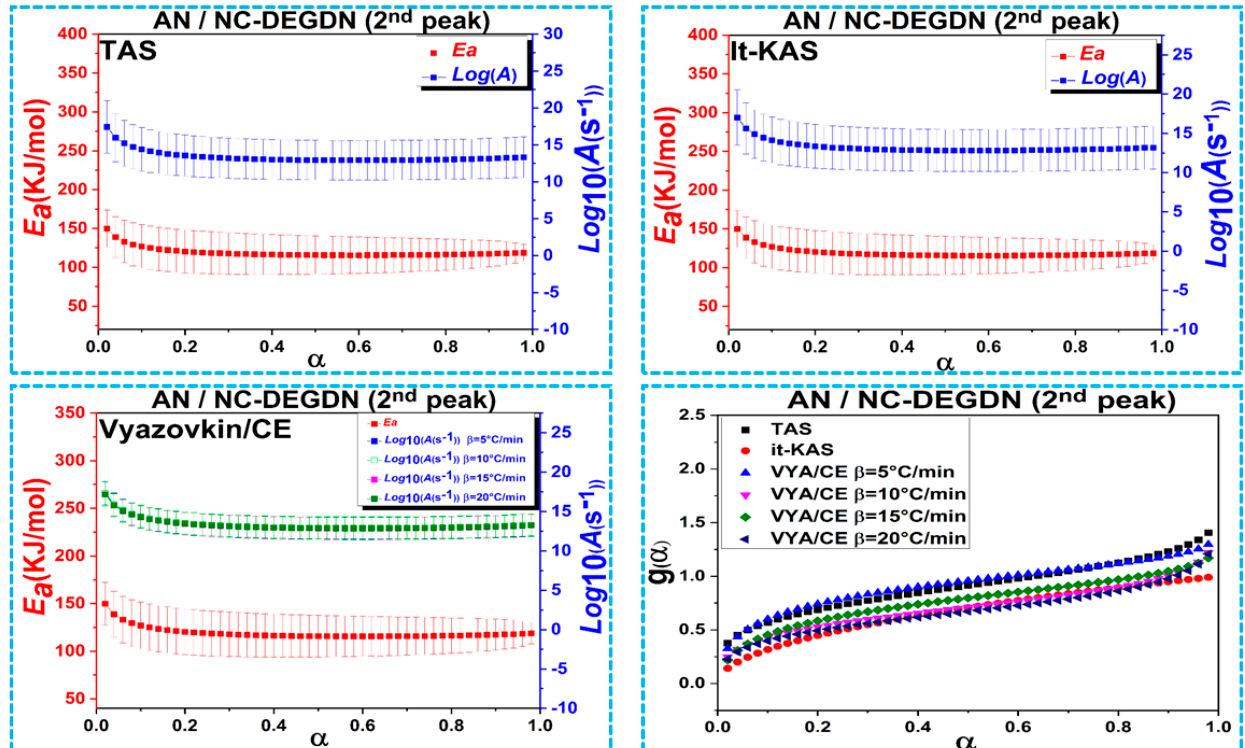
Figure 6. Variation of the kinetic parameters versus conversion for the second thermal decomposition event of AN/NC-DEGDN propellant.